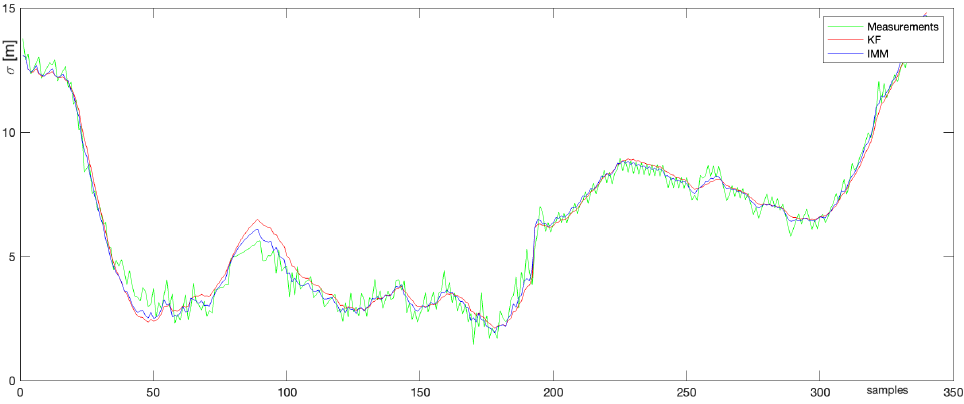
Figure 15. Comparison of estimation